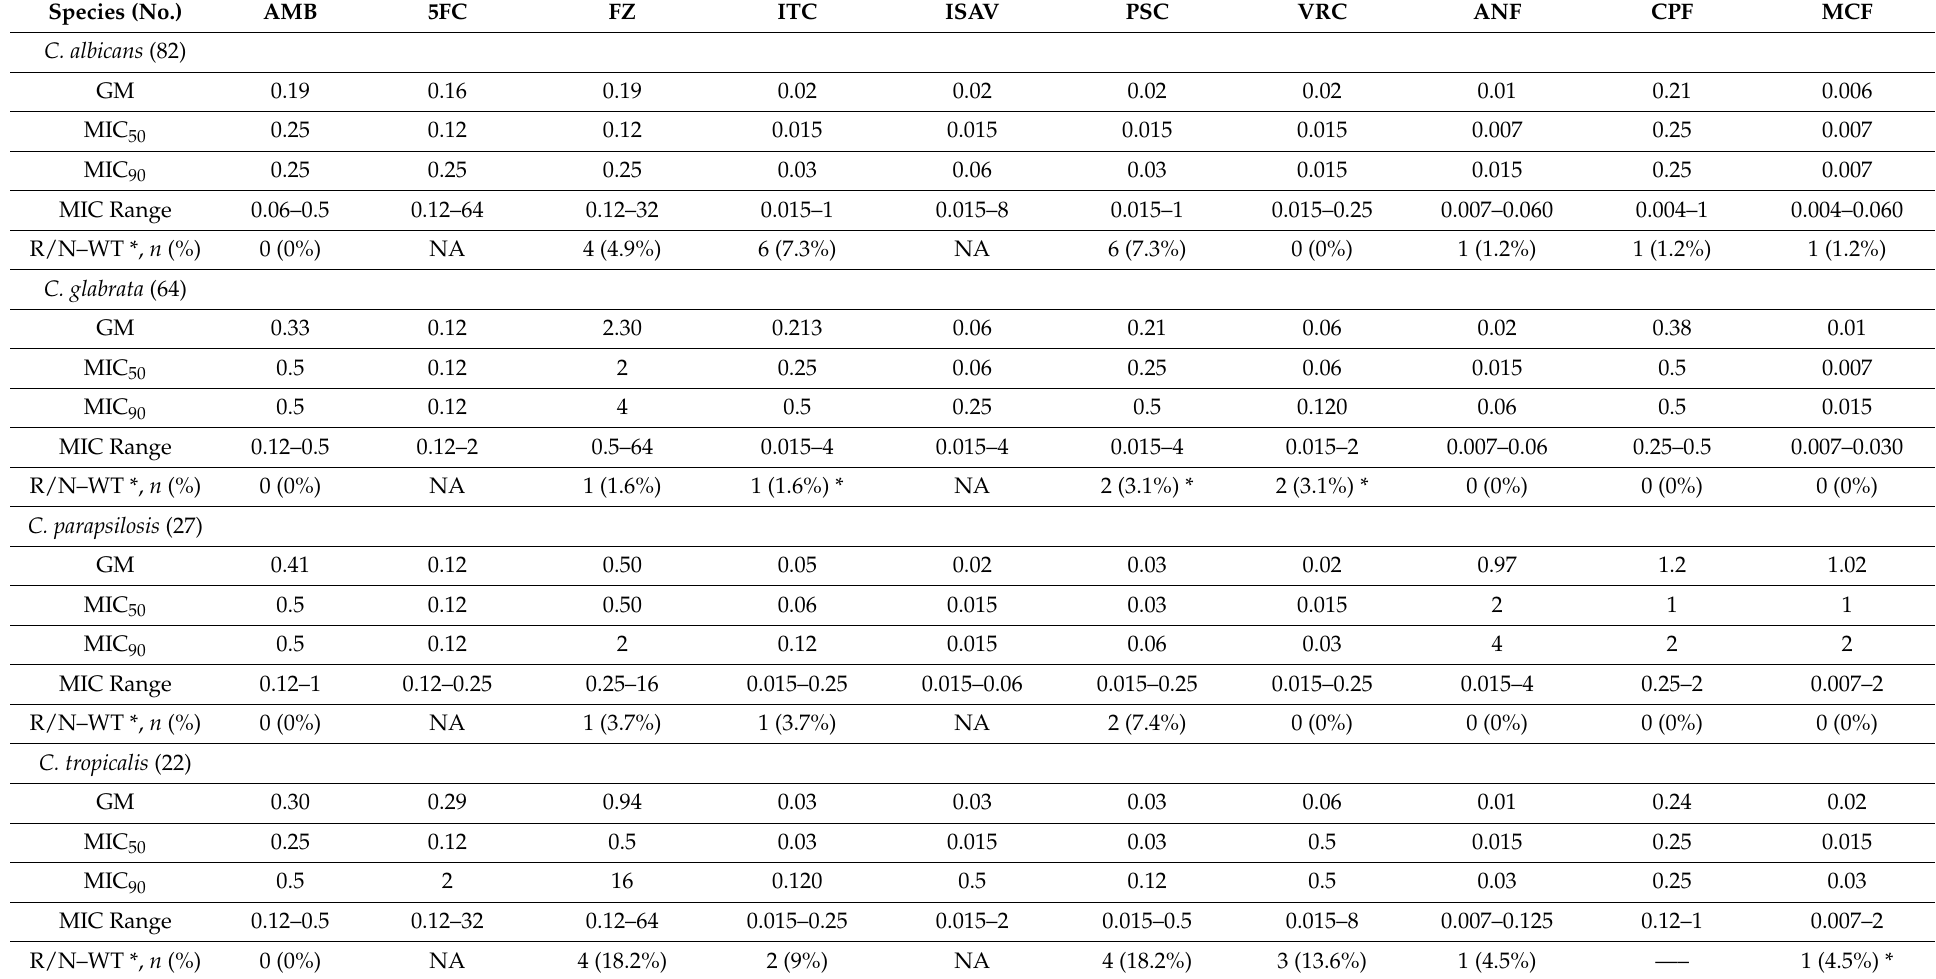
Table 4. In vitro antifungal activities of the isolates